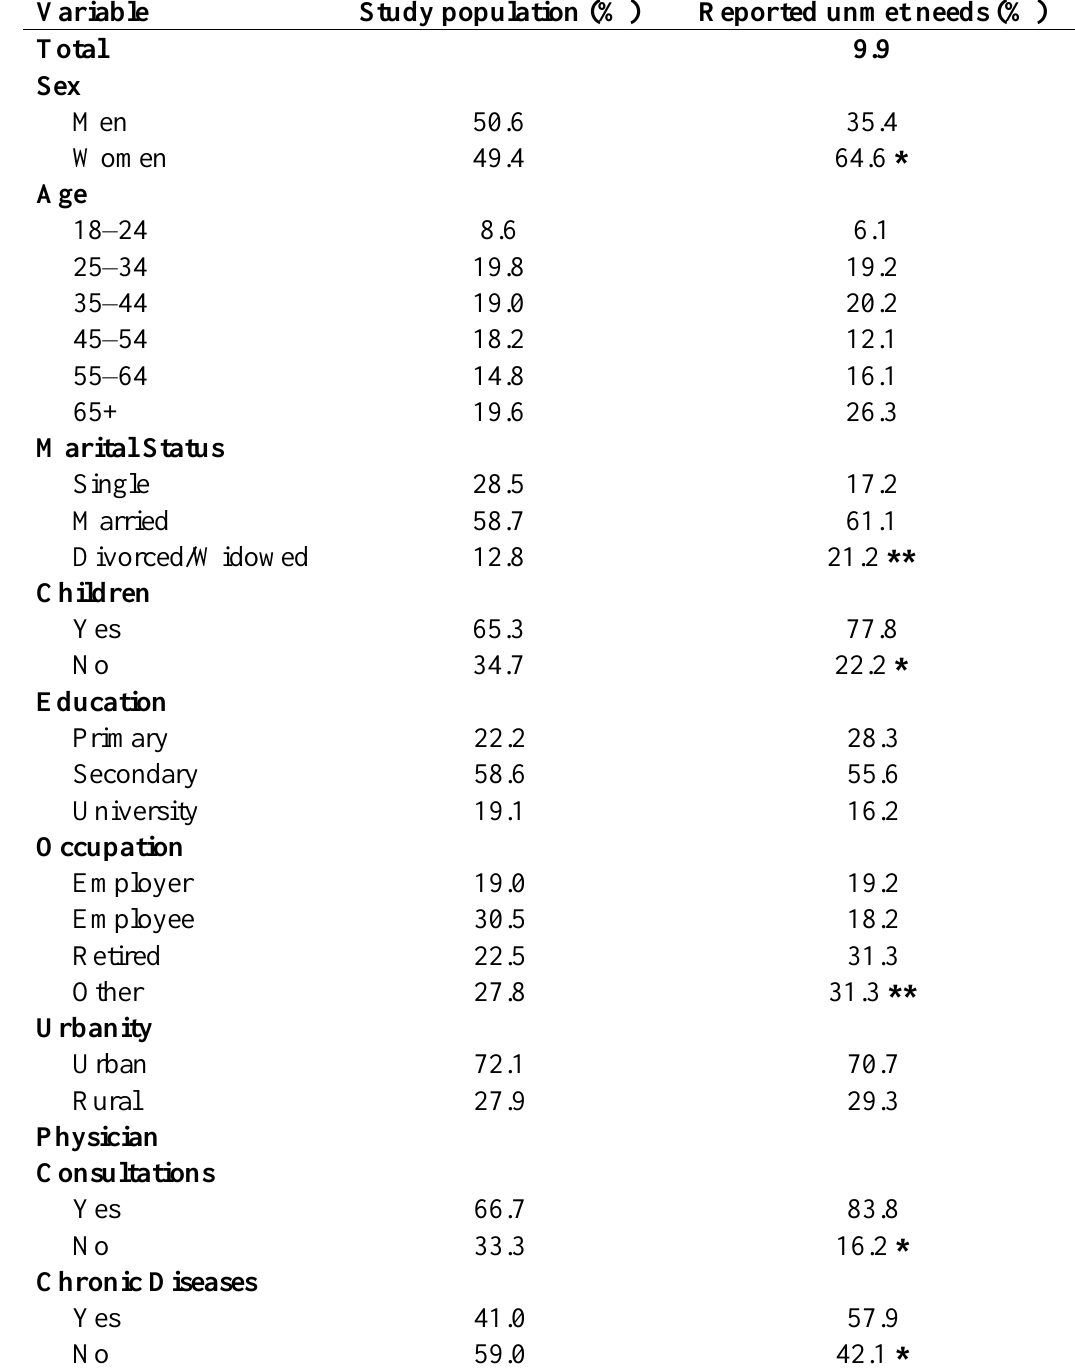
Table 1. Descriptive characteristics of the study population and those who reported unmet needs.